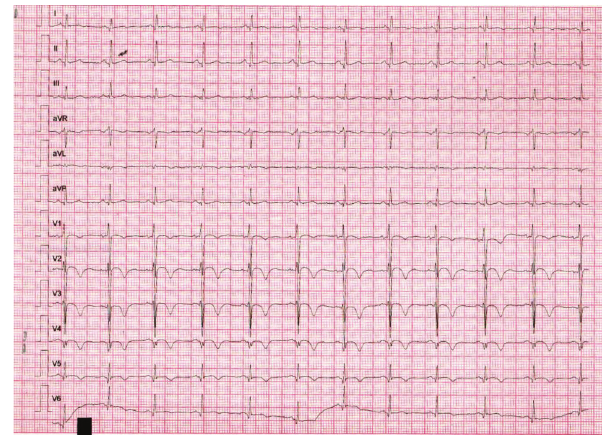
Figure 2: Electrocardiogram obtained during the episode of chest pain. It shows inversion of T wave in leads I, aVL, and V2–V6. There is poor progression of the R wave.